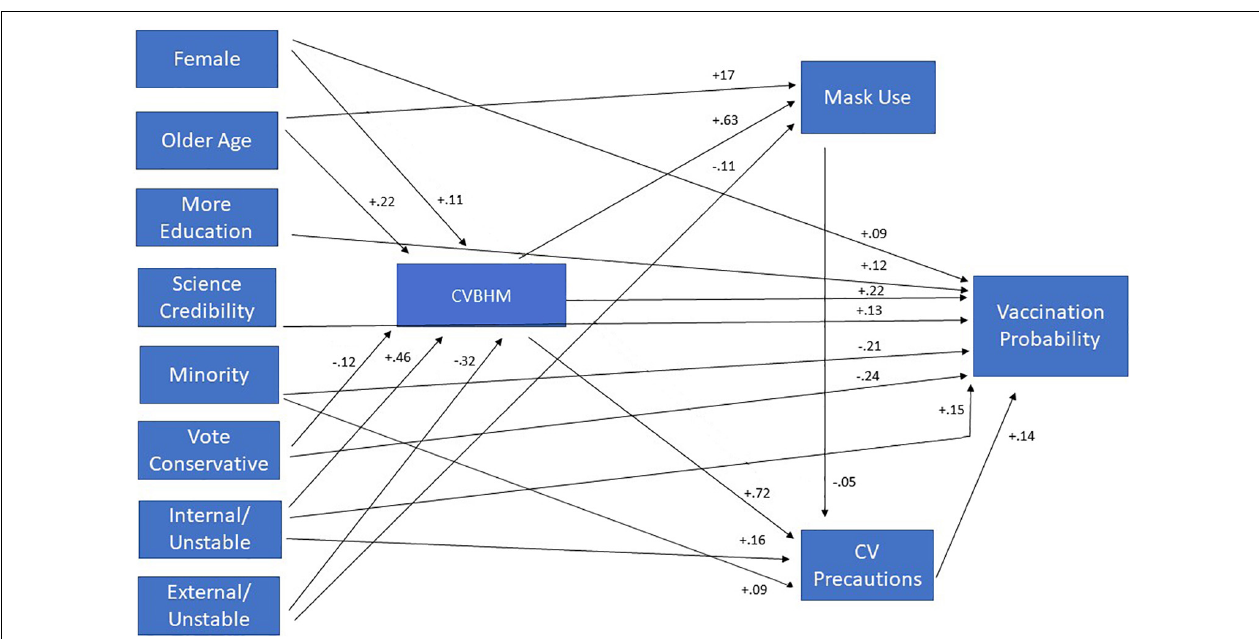
FIGURE 1 | Path model between demographics, attitudes, attributions and COVID-19 safety